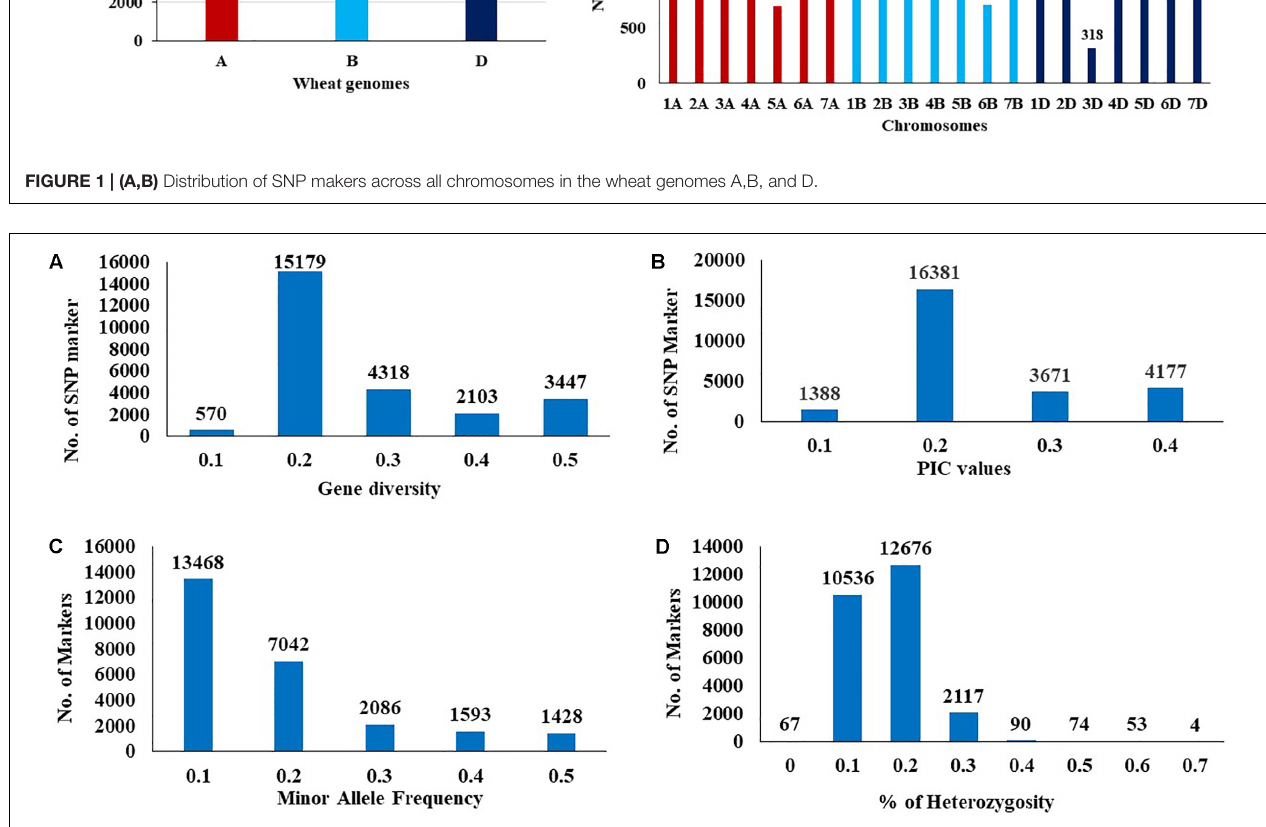
FIGURE 2 | Distribution of genetic diversity (A) , polymorphic information content (PIC) (B) , minor allele frequency (C) , and percentage of heterozygosity (D) for 25567 SNP marker in the 230 Nebraska wheat genotypes.